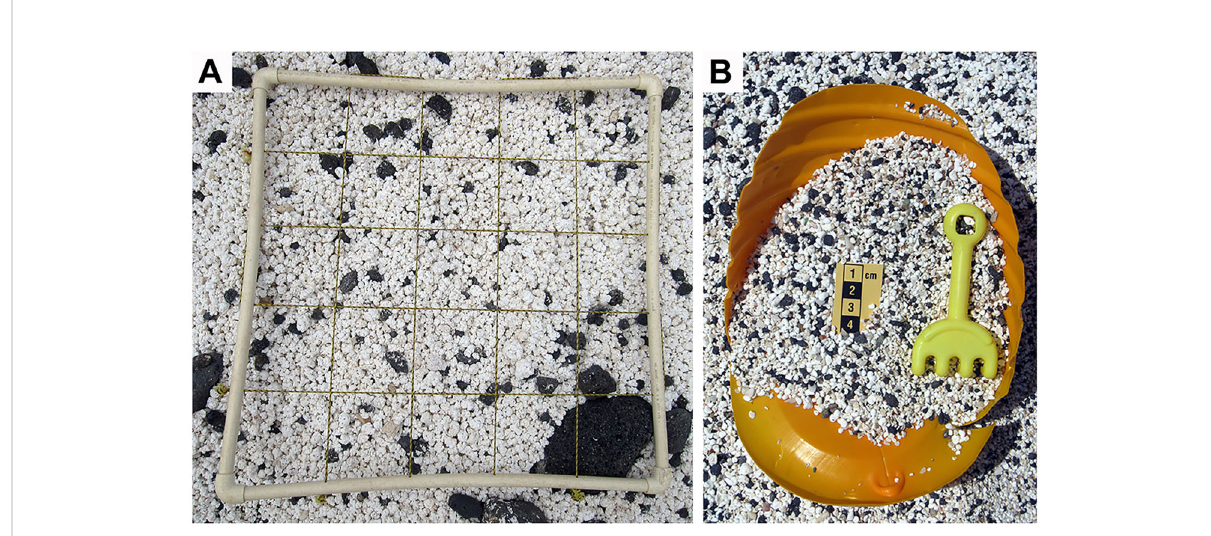
FIGURE 4 (A) Standard sample quadrat (50 x 50 cm) on “ popcorn beach ” at L2 - Caleta del Bajo de Mejillones on the north shore of Fuerteventura Island. Each square is 10 cm x 10 cm. Approximately 200 rhodoliths may be counted per unit, (B) close-up view of fi nely degraded rhodolith material –